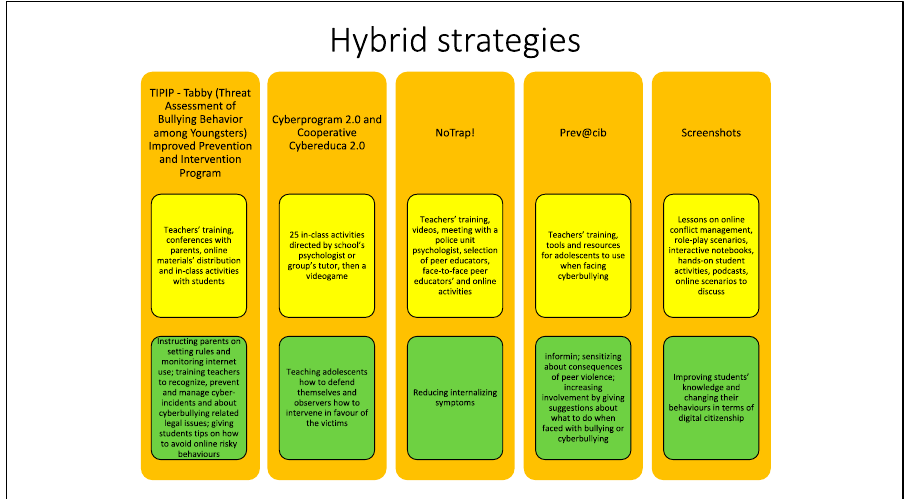
Figure 5. This figure summarizes descriptions and objectives of the hybrid strategies that will be presented below. The name of the strategy is reported in orange boxes. Yellow boxes contain different strategies’ descriptions, while objectives are stated in the green boxes.